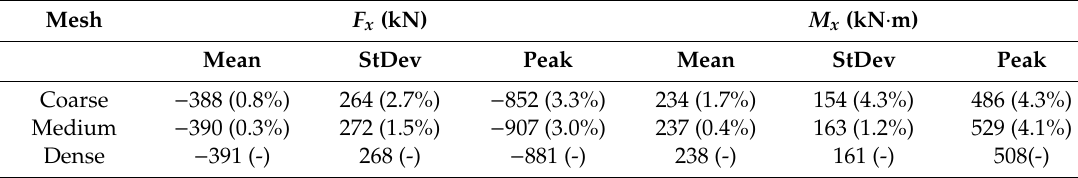
Figure 11. Time histories of ice loads for cases with different meshes. ( a ) The Fx with different meshes. ( b ) The Mx with different meshes. Table 4. Comparison of ice loads for cases with different meshes.